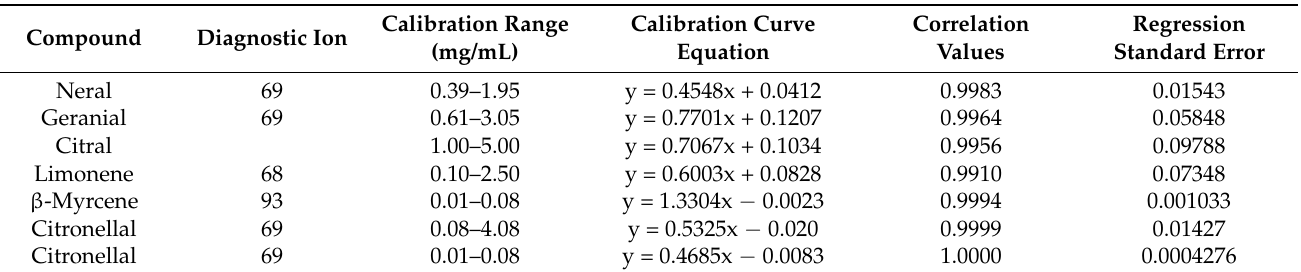
Table 2. Diagnostic ions ( m / z ) used for SIM-MS quantitation of selected marker compounds that characterize the investi- gated essential oils together with the calibration range, the calibration curve equation, correlation values, and regression standard error.